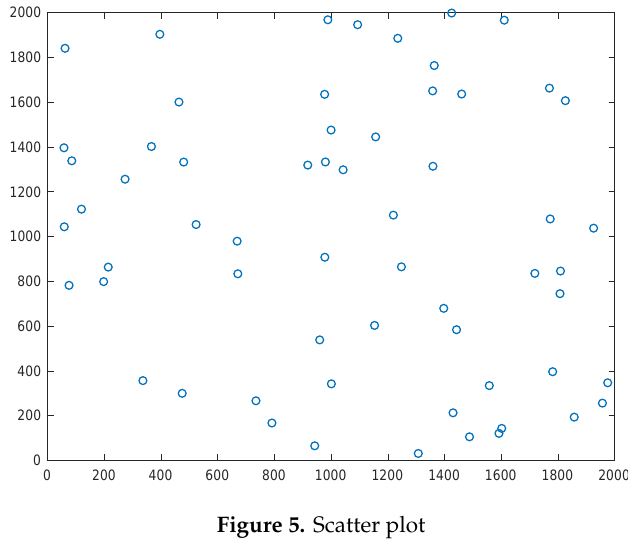
Figure 5. Scatter plot